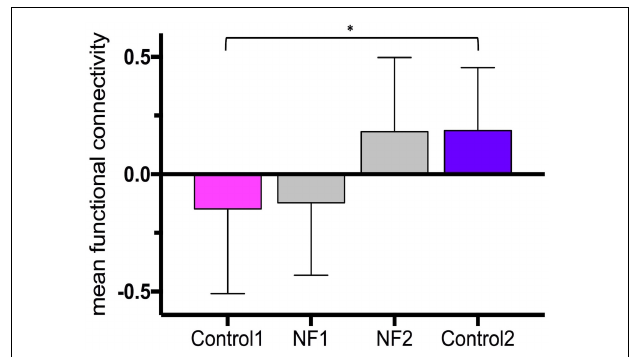
FIGURE 4 | Neurofeedback learning. The bar graphs show the mean right insula-dorsomedial frontal cortex functional connectivity (i.e., z-transformed correlation values) averaged across subjects and task blocks. Control 1, first control scan without neurofeedback; Control 2, last control scan without neurofeedback; NF 1, neurofeedback scans on day 1; NF 2, neurofeedback scans on day 2. ∗ p = 0.009.